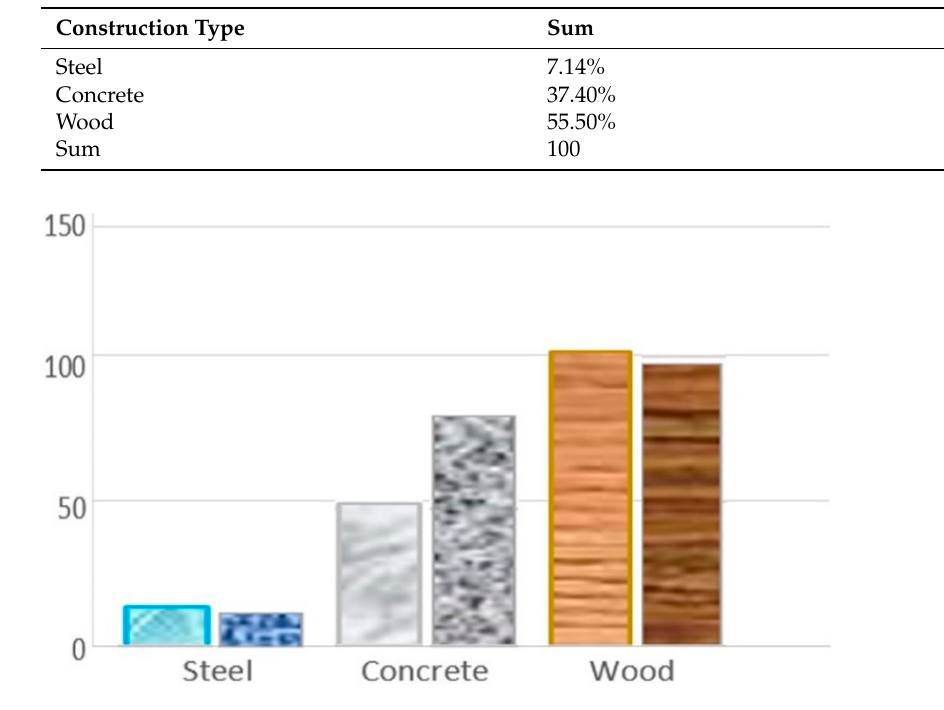
Figure 11. Social aspects for PCMs: preference towards CMs’ selection between 500 participant sam- ples.